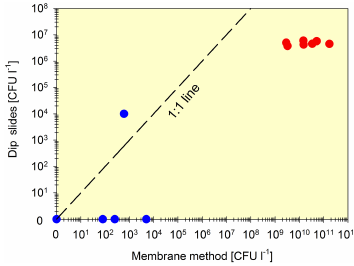
Figure 4. Comparison of dip slides with the accredited membrane method. Blue: samples of drinking water and bottom buckets during the final low filling scenario; red: samples of top